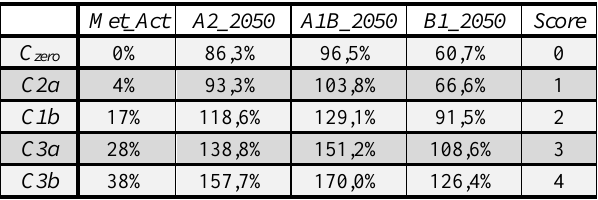
Table 3 - Score of priority on cooling impact for Building type zero evaluated in the combinations of buildings